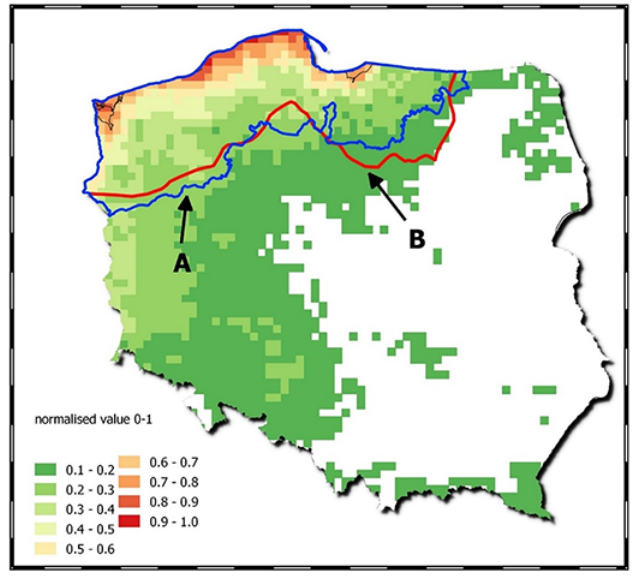
Fig. 6 Results of the MaxEnt analyses of the normalized sum averaged by 100 outputs grids where the bootstrap model is equal or higher than 0.6. ( A ) Southern border of geobotanical distinction of Pomerania according to Matuszkiewicz [4]. ( B ) Southern border of geobotanical distinction of Pomerania according to Szafer